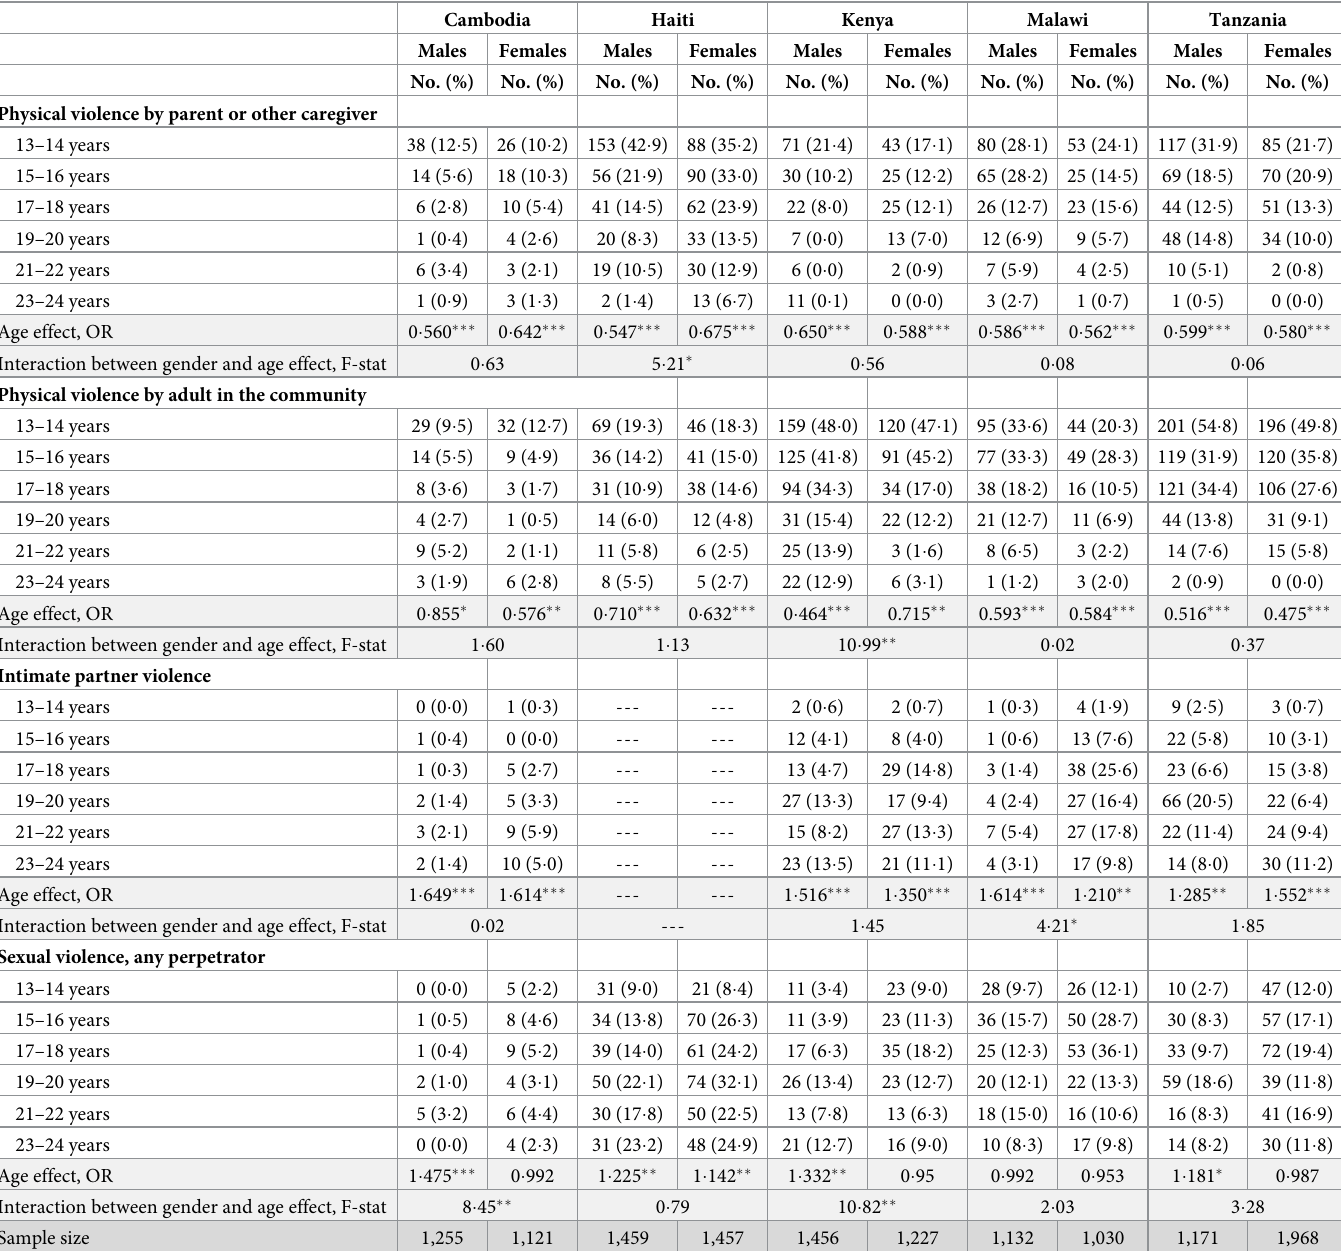
Table 2. Sex and age effects for past-year exposure to